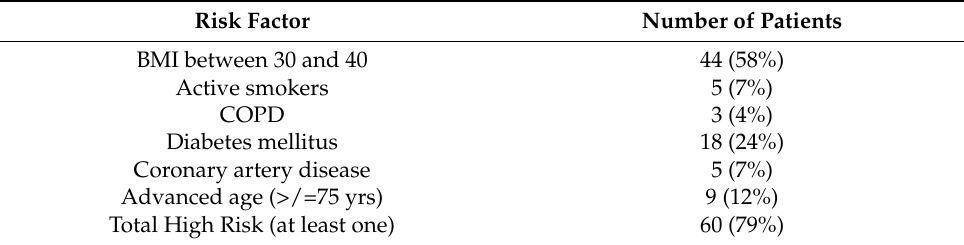
Table 4. Factors for High Risk of Complications, One-Year